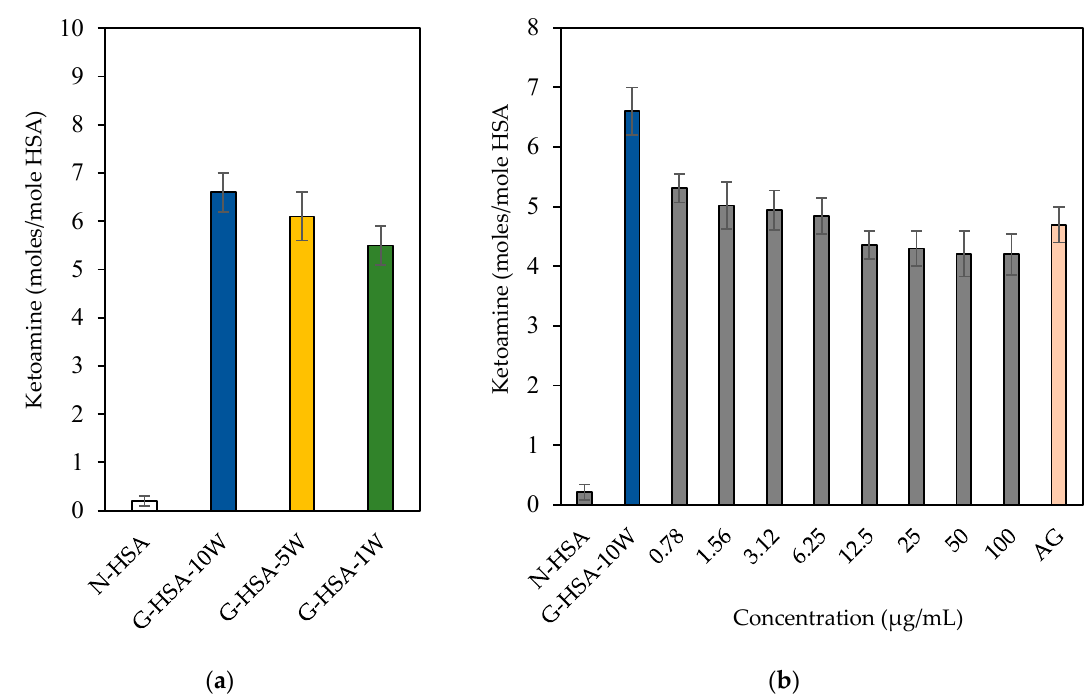
Figure 2. Formation of ketoamines in the process of glycation with different incubation times (1, 5, and 10 weeks) ( a ). Effect of garlic extract on the formation of ketoamines in the process of HSA glycation ( b ), different concentrations of garlic extract (0.78–100 µg/mL) were incubated with glycation reactions for 10 weeks. All the reactions were incubated under similar conditions. Data is presented as mean ± SD values. t test was adopted for the comparison between the non-glycated and glycated samples as well as between G-HSA-10W alone or with garlic extracts.